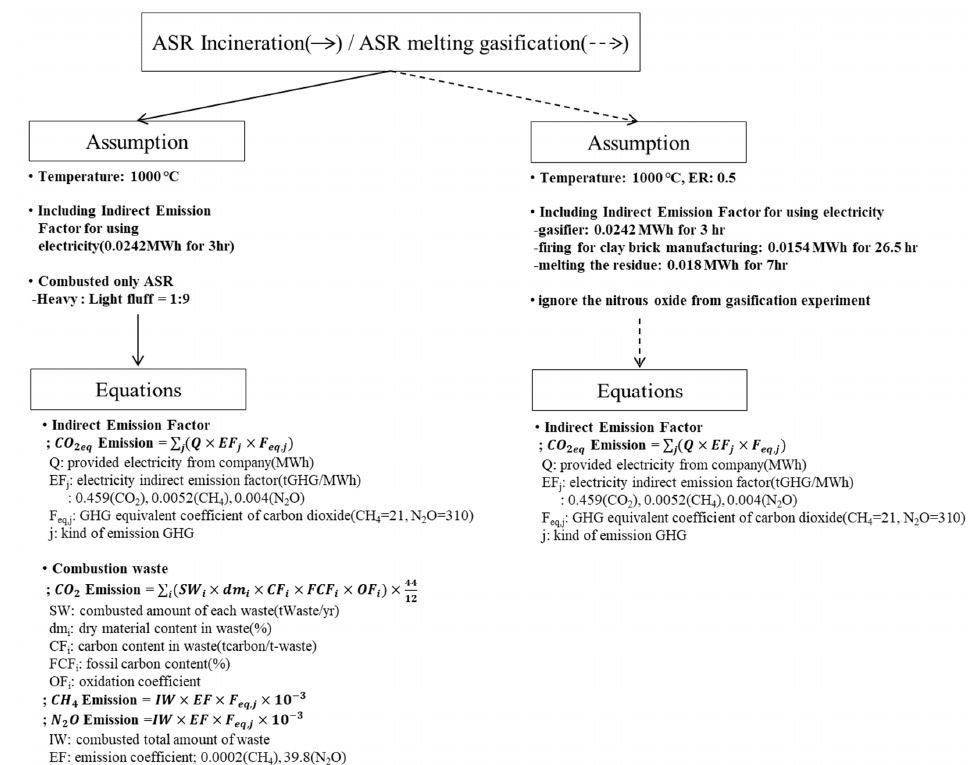
Figure 3. Concept for GHG Emission Estimate